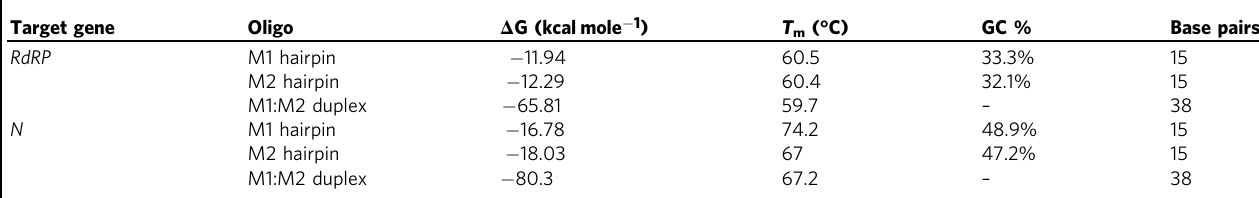
Table 3 Analytical data corresponding to the predicted binding energy ( Δ G ), melting temperature ( T m ), GC content (GC%), and base pair formation of different